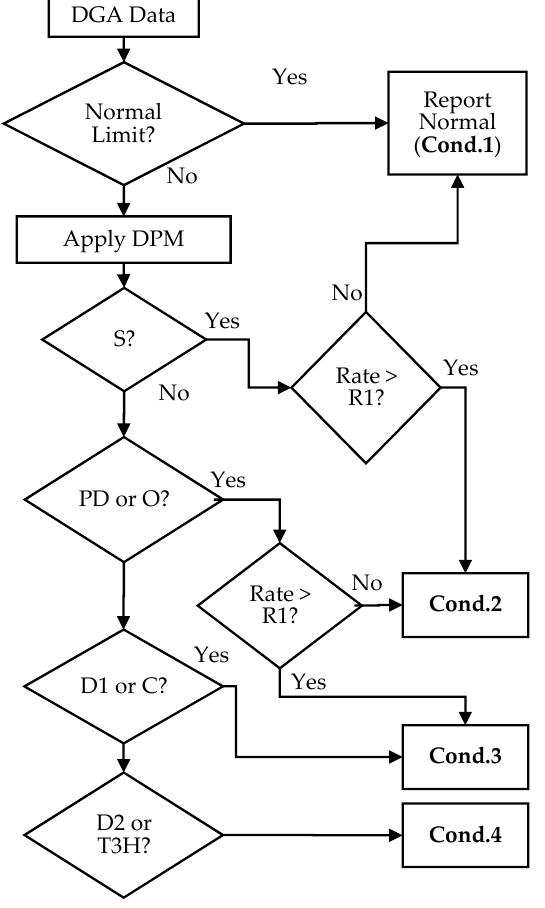
Figure 6. Flowchart of four-conditions classification from DPM results.